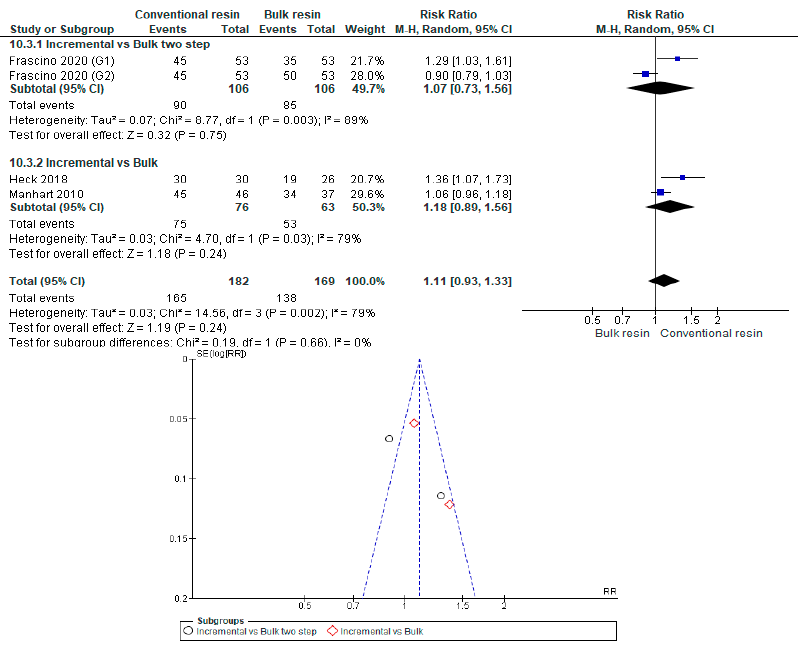
Figure A45. Adequate Restoration Integrity: Conventional Resin versus Bulk Resin According to the